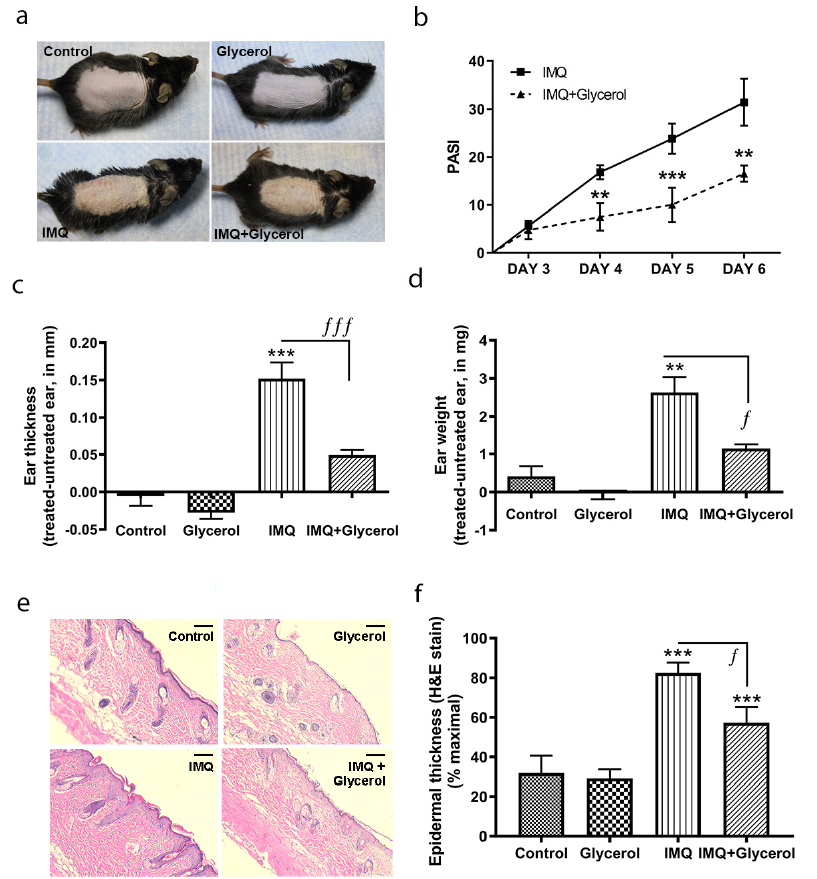
Figure 1. Topical glycerol improved IMQ-induced psoriasiform lesions in wild-type C57BL/6 mice. Daily for five days, five hours after IMQ or vehicle (petrolatum) application, water or glycerol was applied topically as a 50% (volume:volume) glycerol in water solution to wild-type C57BL/6 mice. ( a ) Representative photographs (day 6) showing effects on epidermal erythema, thickening and scaling with treatments. ( b ) Psoriasis area severity index (PASI) scores analyzed by unpaired, two- tailed t-tests comparing two groups within the same day. ( c ) Ear thickness and ( d ) ear biopsy weight measured as described in Methods. ( e ) Representative hematoxylin- and eosin (H&E)-stained micrographs showing back skin epidermal thickening with IMQ treatment (scale bar = 100 µ m). ( f ) Quantitation of the thickness expressed as the percent maximal value, presented as means ± SEM ( n = 4–5), with one-way analysis of variance (ANOVA) followed by Student–Newman–Keuls multiple- comparison post-hoc tests (GraphPad Prism, La Jolla, CA, USA) used to determine significant differences; ** p < 0.01, *** p < 0.001 versus control; ƒ p < 0.05, ƒƒƒ p < 0.001 as